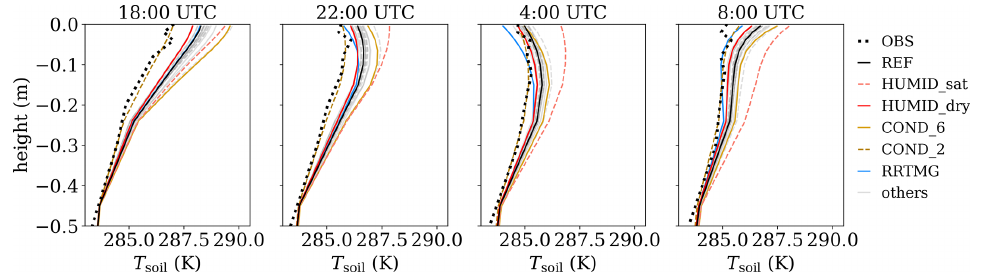
Figure 8. Vertical profiles of soil temperature as measured at Cabauw (OBS) and domain-averaged soil temperature for all simulated cases listed in Table 5. Only case REF and some relevant cases are highlighted; all others are shown in